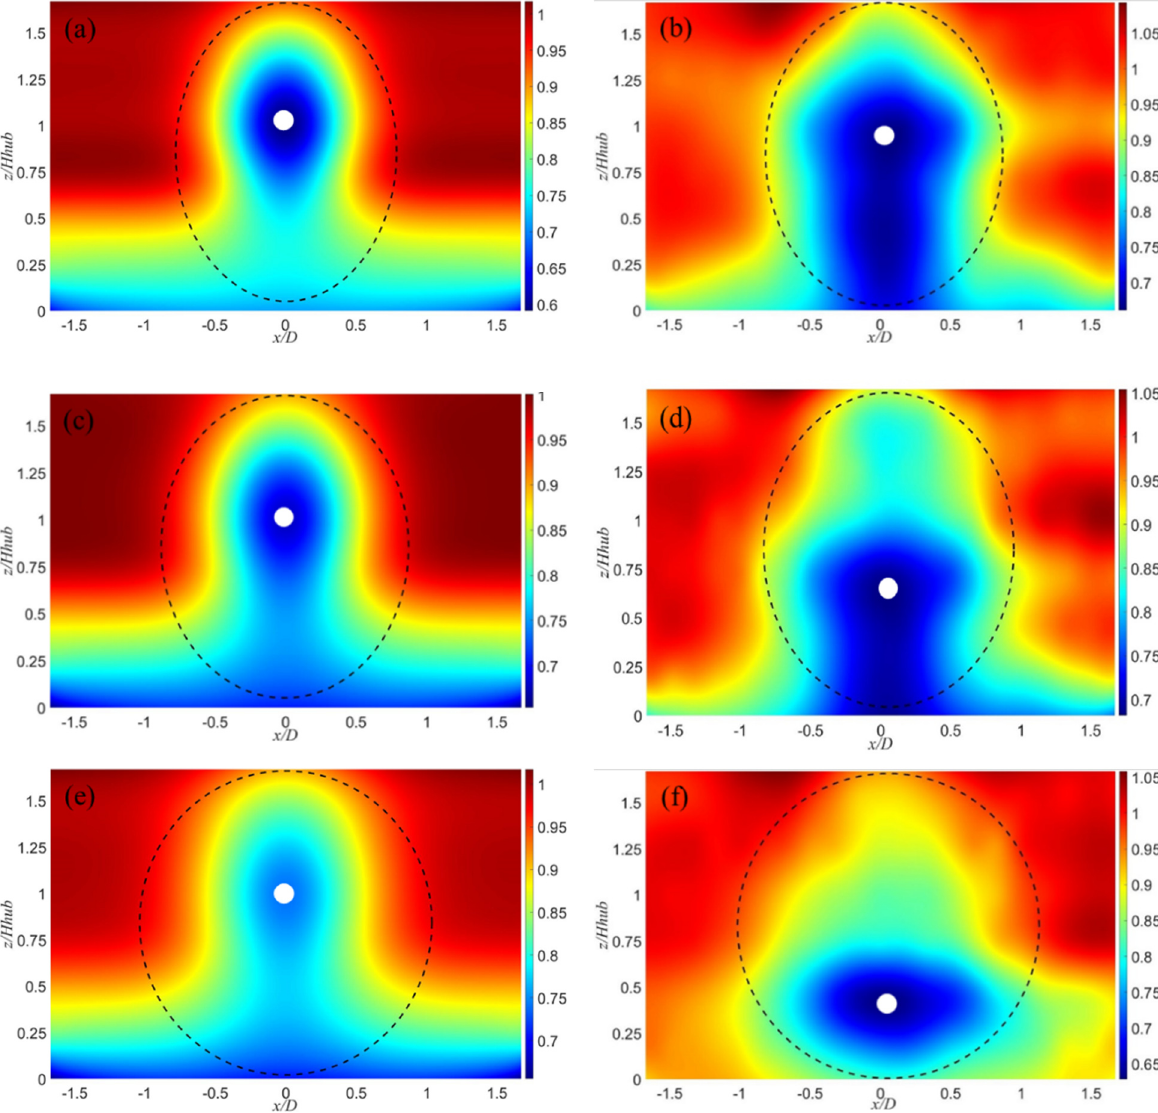
Figure 8. Contours of normalized mean velocity of the Gaussian wake model and the thrust-optimized model for U06-Iu06- γ 00 - Opt case. ( a ), ( c ), and ( e ) are Gaussian wake model at x / D = 4, 5, and 6, respectively; ( b ), ( d ), and ( f ) are thrust-optimized model at x / D = 4, 5, and 6, respectively.